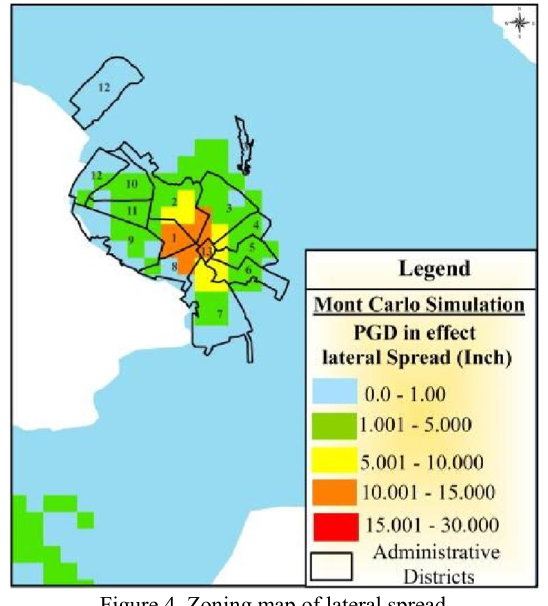
Figure 4. Zoning map of lateral spread